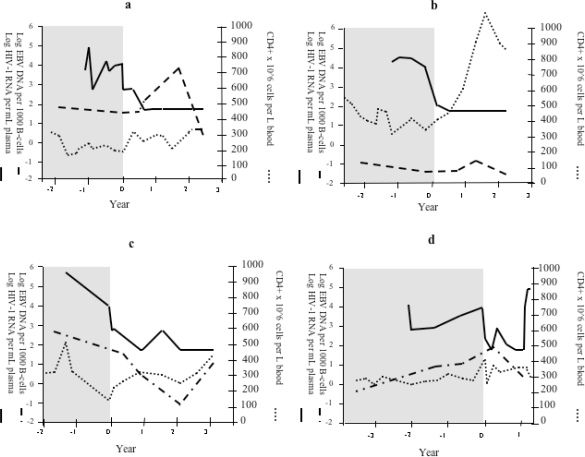
Examples of individual responses of patients from all three groups. EBV load (10-log) (dashed line), HIV-RNA titer (10-log) (solid line), and CD4+ cell count (dotted line) over time. Time 0 is defined as the start of cART. Time before cART is shadowed. Panel (a) and (b) represent two patients from group I. Patient A had CD4+ cell count of 200 × 106/L the year before cART; patient B had a median CD4+ cell count of 380 × 106/L the year before cART. (c) Example of a patient from group II. (d) Example of a patient from group III.